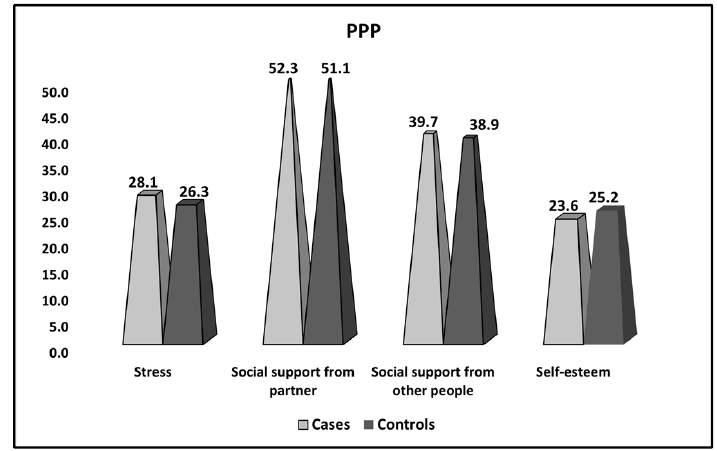
Figure 4. PPP survey results between women with thrombophilia and recurrent pregnancy loss